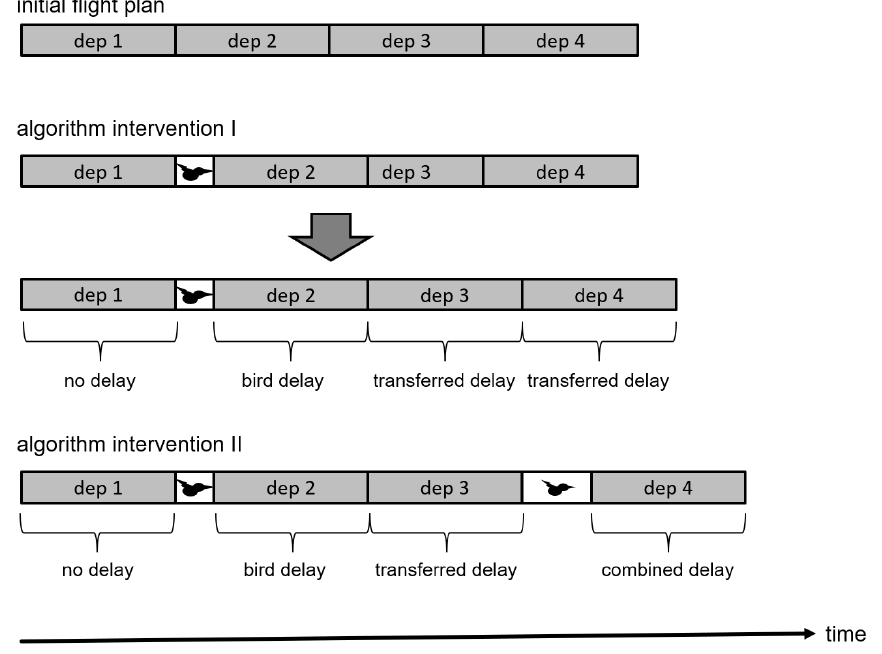
Figure 4. Types of delays generated by the